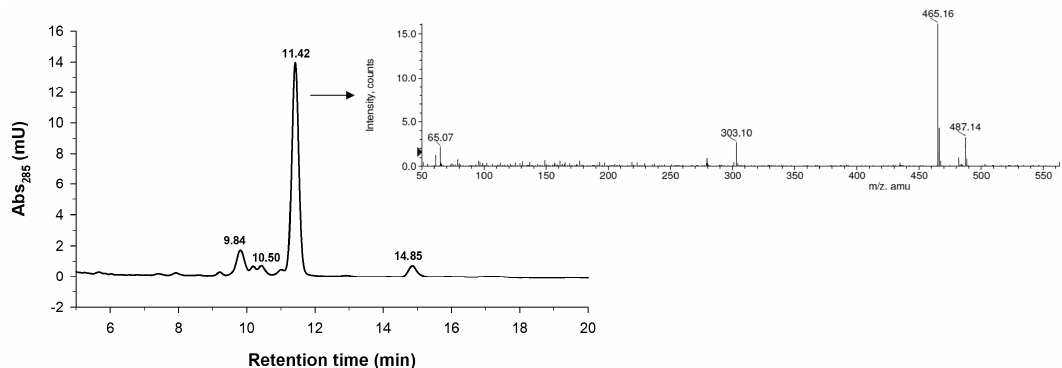
Figure 1. HPLC-MS chromatogram of the reaction mixture after 27 h showing the glucosides of hesperetin obtained with the CGTase from Thermoanaerobacter sp. Inset: Mass spectrum (ESI-TOF in positive mode) of the main peak at 11.42 min. Reaction conditions: Hesperetin (20 mg/mL), soluble starch (45 mg/mL), 10 mM sodium acetate buffer (pH 5.6), 35% acetonitrile, CGTase from Thermoanaerobacter sp. (5% v / v ), 50 °C, 150 rpm.